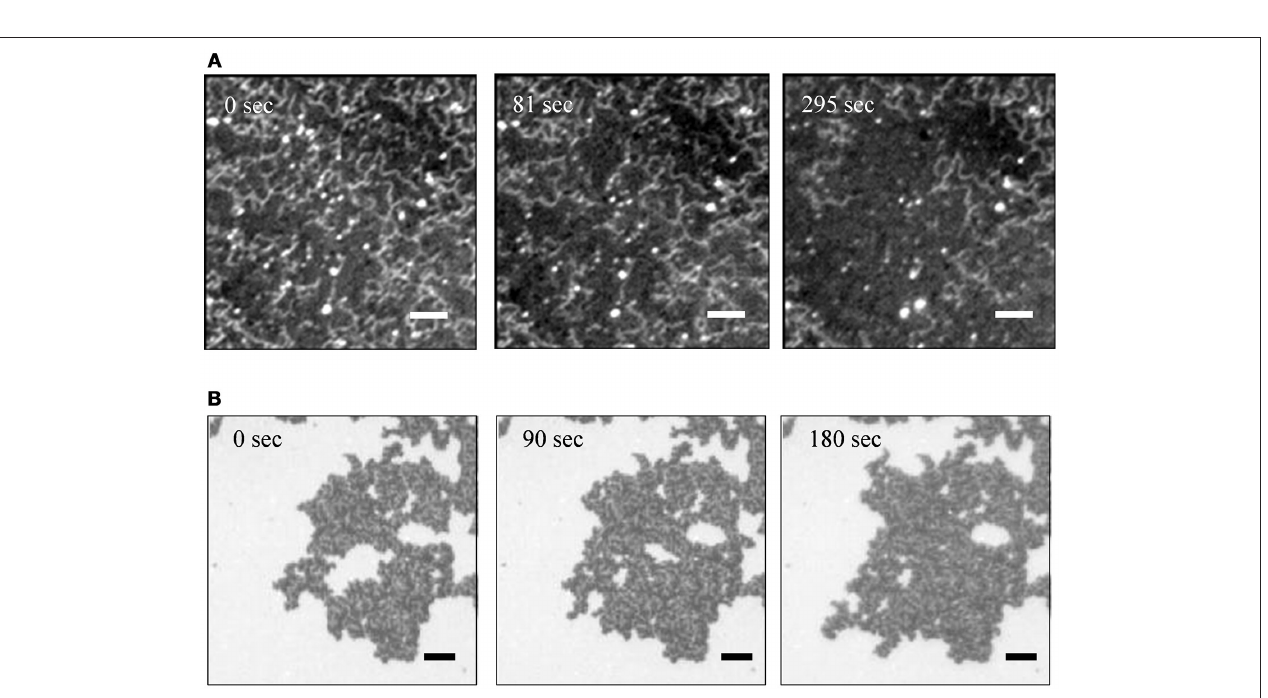
FIGURE 4 | Sequential fluorescence images of PLE-SLBs with [Ca 2 + ] = 3.0mM focusing to (A) the string-like structure and (B) the second bilayer two times brighter than the surrounding. The images of (A,B) were obtained from two samples independently. Scale bars are 10 µ